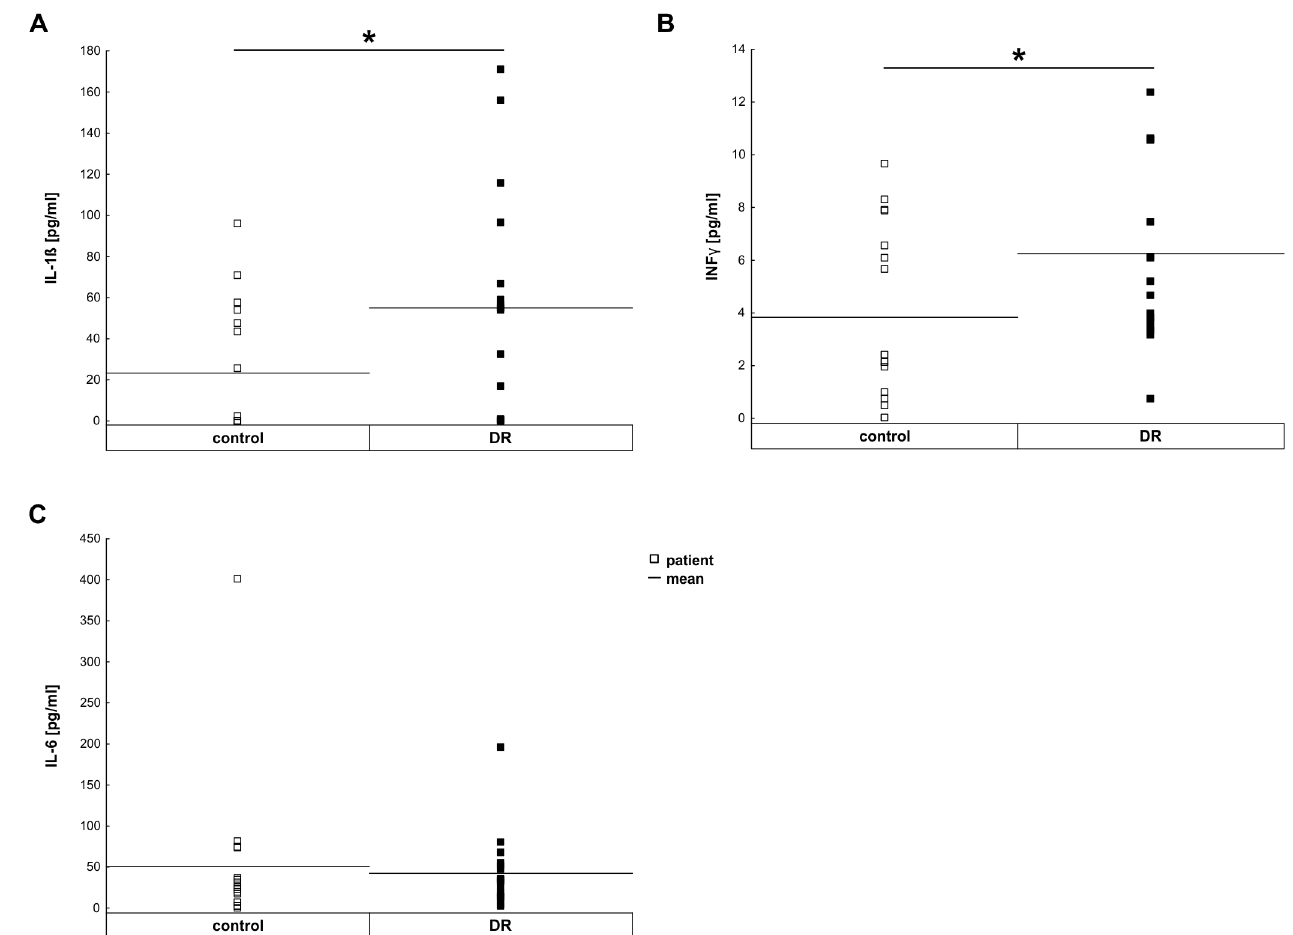
Fig 1. Increased pro-inflammatory cytokine levels in vitreous samples. A. The pro-inflammatory cytokine IL-1ß (p = 0.02) was significantly up-regulated in compassion to the controls. B. INF- γ (p = 0.04) was also significantly up-regulated. C. In contrast, IL-6 expression level was the same in DR and control patient (p = 0.51). Each symbol depicts an individual patient. The horizontal bar indicates the mean cytokine concentration per group. (cid:3) : p < 0.05.